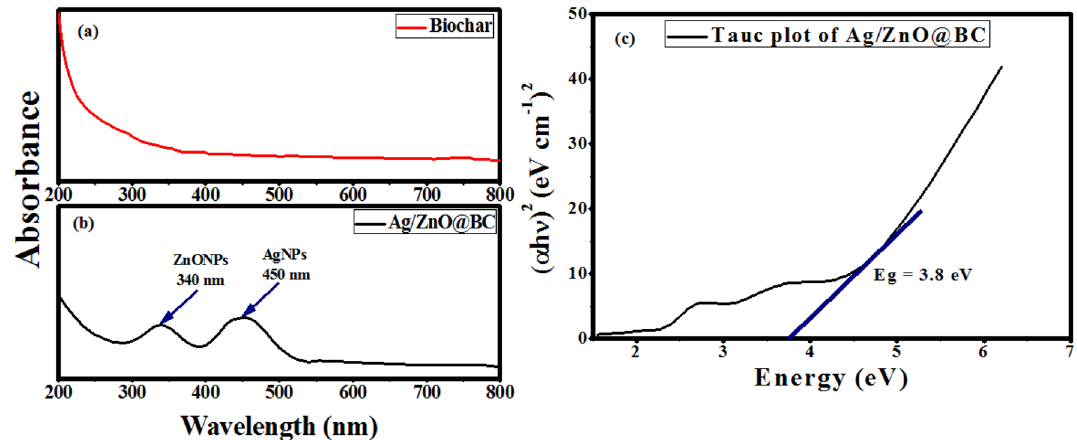
Figure 2. UV–visible spectra of Biochar ( a ) and Ag/ZnO@BC ( b ) Tauc plot of ZnO-Ag- biochar ( c